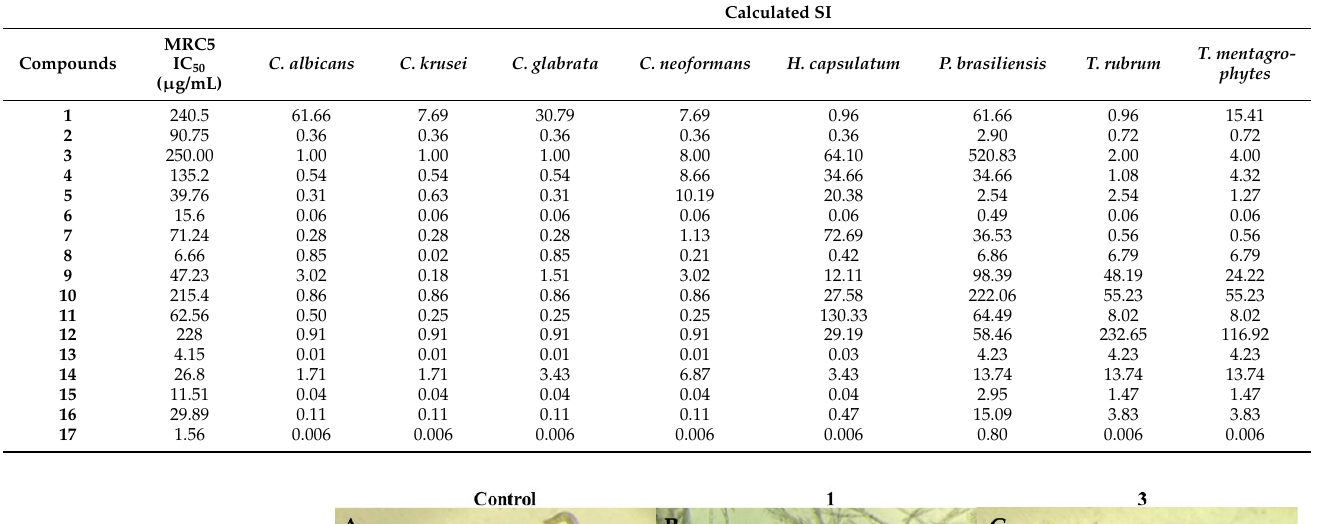
Figure 3. Caenorhabtis elegans larvae viability after treatment with the tested compounds. The larvae viability was greater than 80% with all the tested nitrofurans, even at the highest concentration of the compounds (250 µg/mL). The effects of the compounds were compared to the control group. Nitrofurans 1 and 12 showed no statistical difference with the control group in any concentration. On the other hand, compounds 3 , 5 and 11 , at the concentration of 250 µg/mL, showed statistical difference with the control group, with p < 0.01, p < 0.05 and p < 0.001, respectively. Compound 5 also showed statistical difference with the control group at the concentrations of 125 µg/mL ( p < 0.05) and 62.5 µg/mL ( p < 0.001).